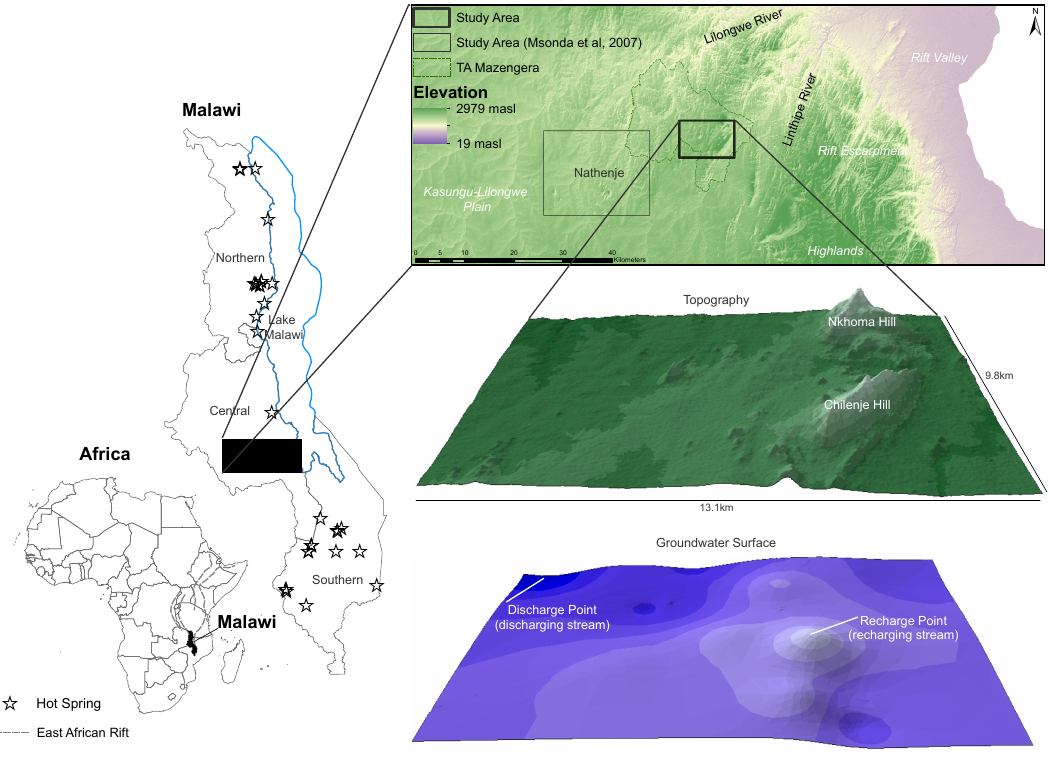
Figure 1. Location of study area within traditional authority (TA) Mazengera alongside Msonda et al. [13] study area at Nathenje area. The figure depicts Malawi’s location within the east African rift system, marks the locations of all known hot springs and provides 3-D visualisation of the study area topography and drainage (2 × vertical exaggeration), above a 3-D visualisation of groundwater surface indicating the main recharge and discharge points (5 × vertical